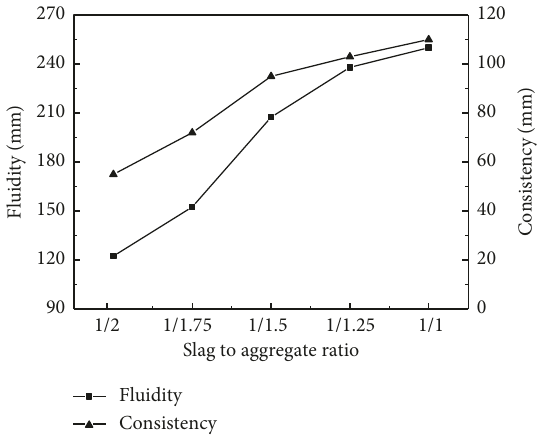
Figure 3: The effect of slag to aggregate ratios on the fluidity and consistency of AAS